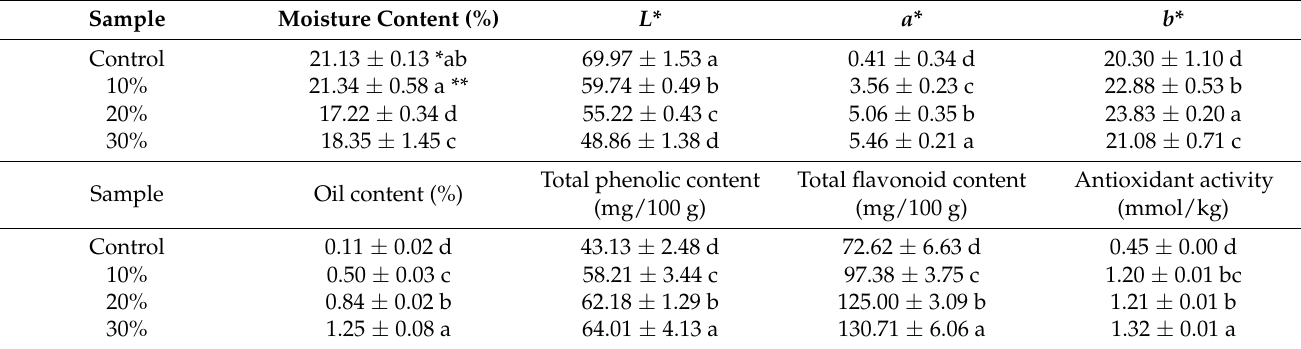
Table 1. Some chemical and bioactive properties of bread samples with coriander seed